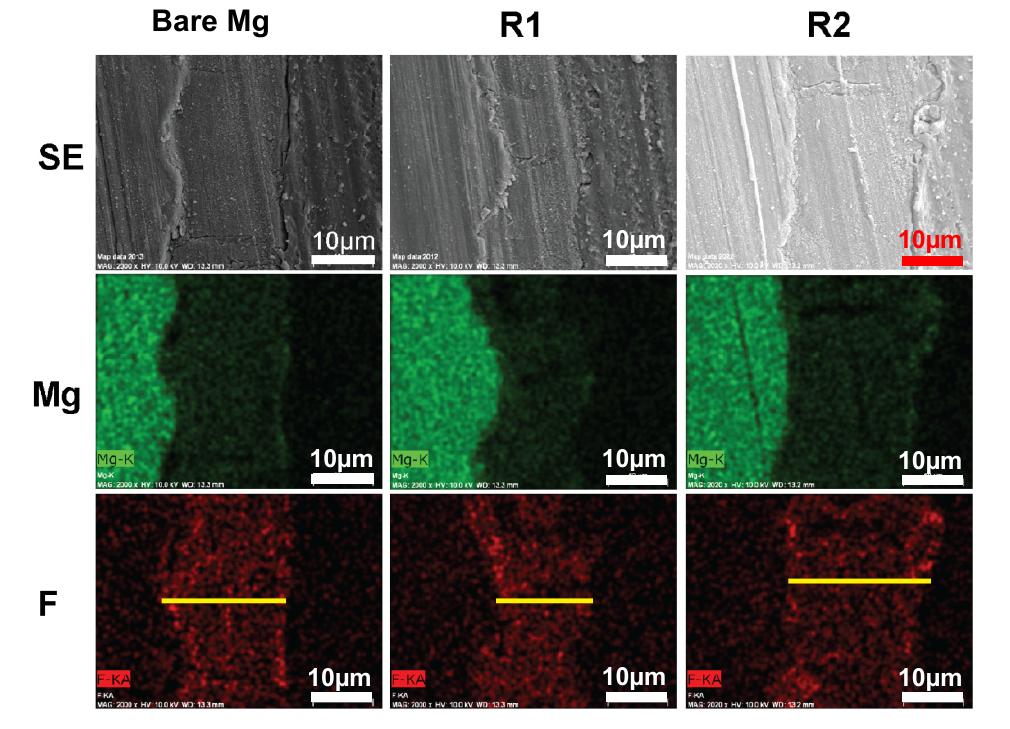
Figure 4. EDS Mapping for cross section of fluoride coating. First row: SEM photos displaying cross sections of magnesium fluoride coating in epoxide resin; Second row: magnesium (Mg, green); Third row: fluorine (F, red). Yellow lines indicate the thickness of fluoride coating (Scale bar: 10